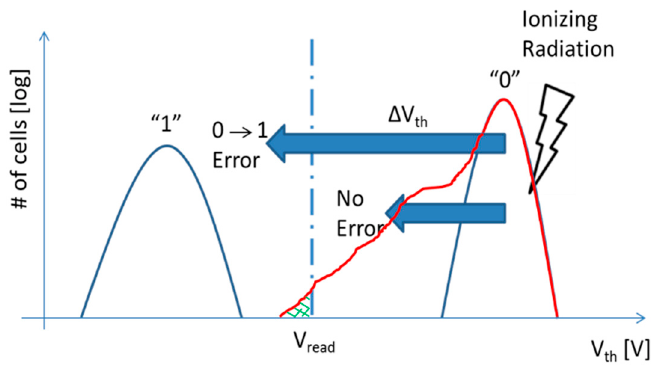
Figure 2. The situation of reading error due to shifted voltage of V TH [2] .